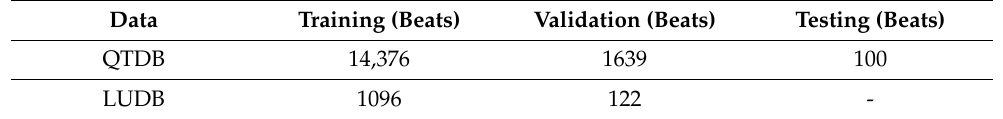
Table 2. The ECG beat segmentation to develop the delineation